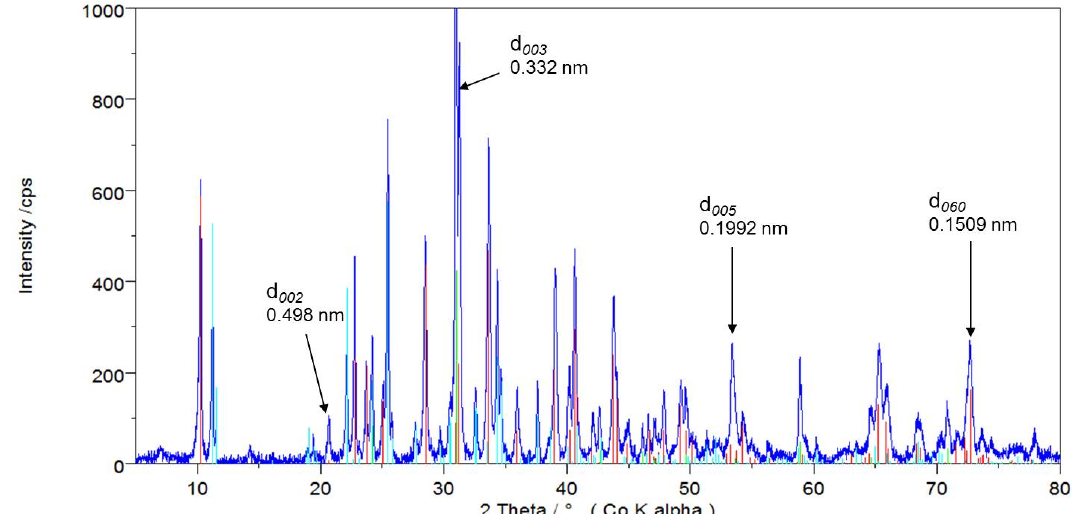
Figure 8. X-ray diffraction pattern of sample Jal 30 (smeared powder on Si low background holder, background corrected); intensity ratios are biased by preferred orientation, beam overflow, and insufficient particle statistics; search-match results in stick patterns: red: celadonite 1M (see arrows, PDF 04-011-7885), light blue: stilbite (Ca) (PDF 01-079-1676), green: quartz (PDF 01-075-8322); the d 060 spacing of 0.1509 nm typically indicates a dioctahedral but iron-rich mica phase.